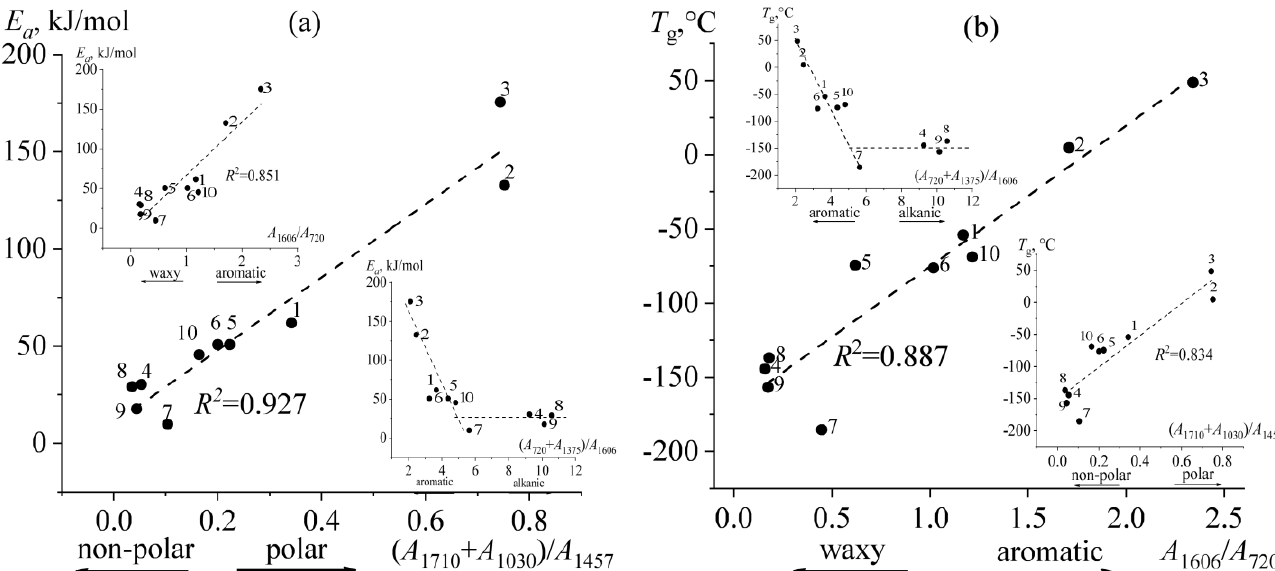
Figure 13. Dependences of ( a ) flow activation energy and ( b ) rheological glass transition temperature on ( a ) polarity and ( b ) aromaticity of bitumens. The insets show the same data but depend on ( a ) the aromaticity and paraffinicity of bitumens or ( b ) their paraffinicity and polarity. Bitumen numbers are indicated near experimental points.